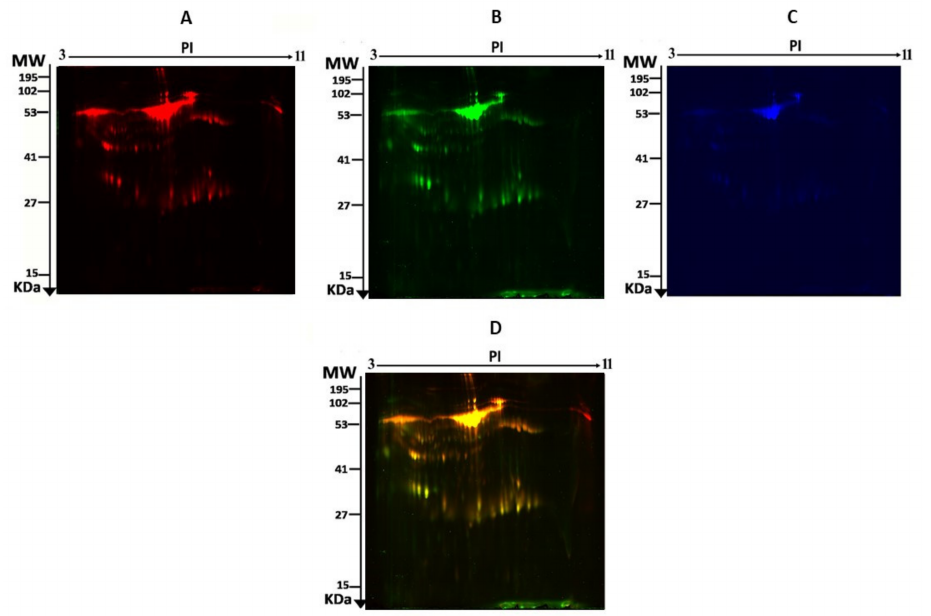
Figure 1. Representative fluorescent protein profile of a two-dimensional difference in gel elec- trophoresis (2D-DIGE) containing urine sample from post-treatment with liraglutide labeled with Cy3 ( A ), pre-treatment labeled with Cy5 ( B ), a pooled internal control labeled with Cy2 ( C ), and a merged image of PRE/POST ( D ).